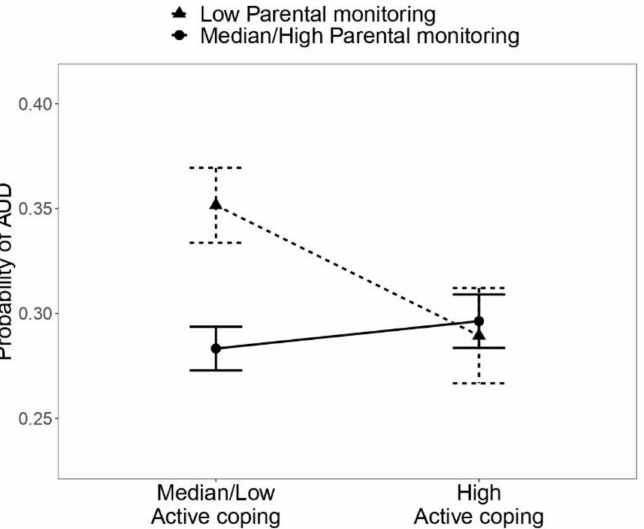
Figure 1. Probabilities of alcohol use disorder predicted by the logistic regression (Model 1) across different levels of parental monitoring and active